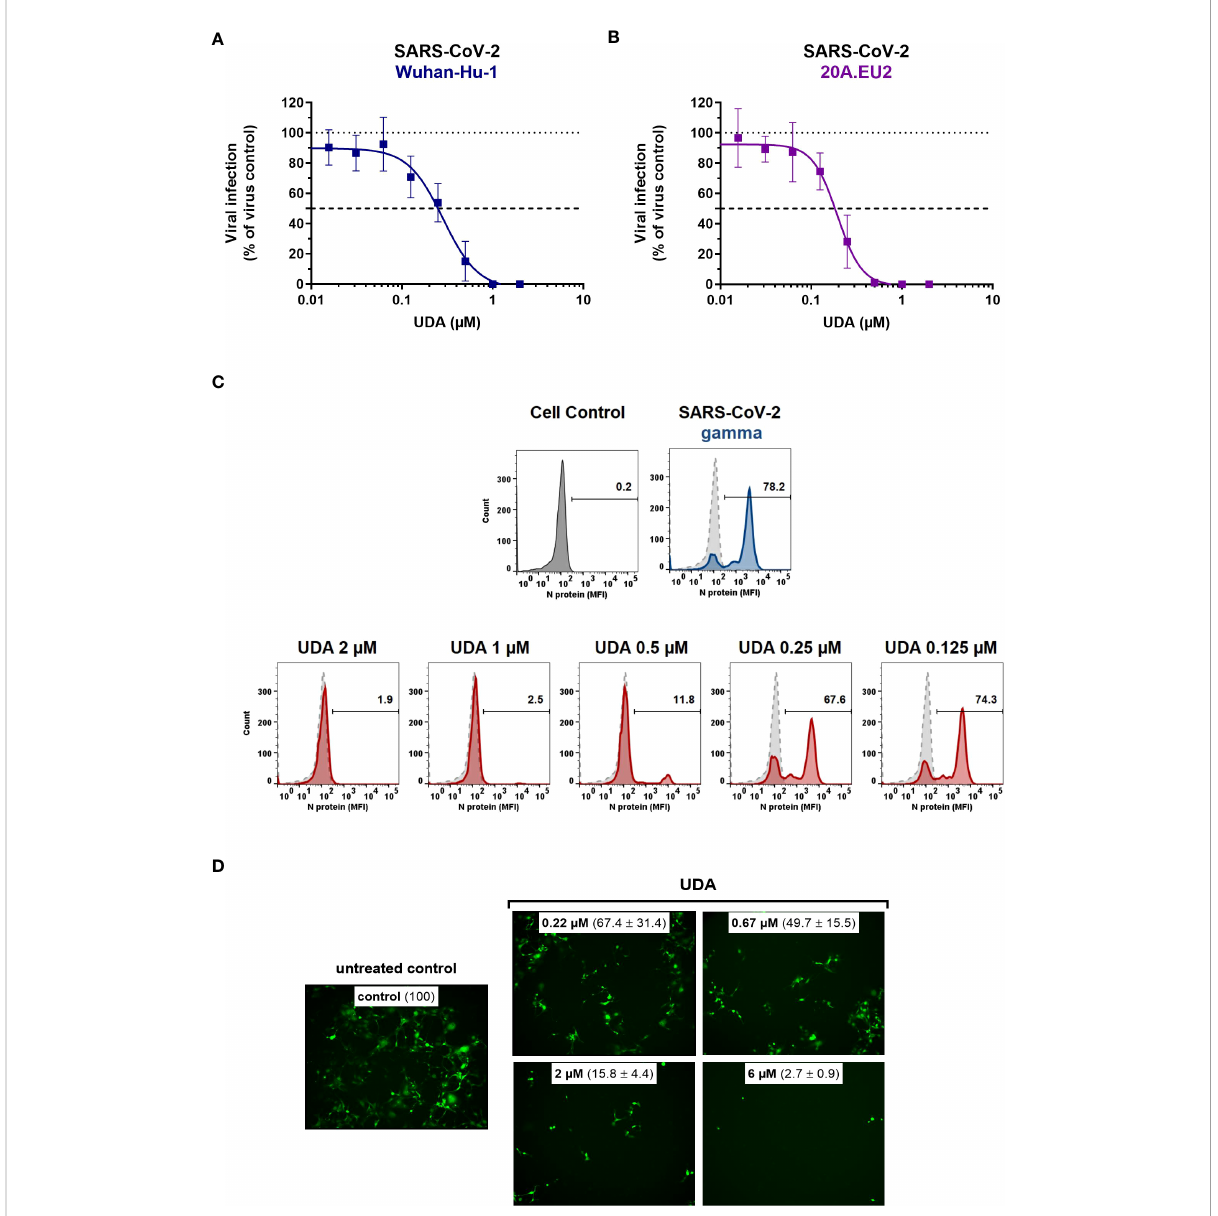
FIGURE 2 Antiviral activity of UDA against live SARS-CoV-2 virus in Vero E6 and U87.ACE2 + cells. Cells were exposed to clinical isolates of SARS-CoV-2, i.e., variants Wuhan-Hu-1 (A) , 20A.EU2 (B) , Gamma (C) or GFP-expressing Wuhan-Hu-1 (D) in the absence or presence of UDA. (A , B) SARS- CoV-2 replication was assessed by RT-qPCR analysis of the viral copy numbers of the N gene in the supernatant at day 3 post infection (p.i.). RT-qPCR data were used to calculate the % inhibition of viral replication and to plot a concentration-response curve for UDA. Graphs show data of 3 independent experiments with 2 technical replicates each (mean ± SD; n=6). (C) Cells were collected at 40h p.i. and stained intracellularly for the viral N protein. Histogram plots show mean fl uorescence intensity (MFI) values of N expression in noninfected (Cell Control; grey), infected (Virus Control; blue) and UDA-treated infected (red) Vero E6 cells from a representative experiment. Single cell analysis was performed on 8,000 – 10,000 cells by fl ow cytometry. The numbers in each plot refer to the percentage of cells that stained positive for N (i.e., infected cells). The dashed grey histogram plot represents the background signal from the non-infected cell control. (D) Pictures, taken at 2 days post infection, show GFP expression in the infected U87.ACE2 + cells. Representative pictures from a biological replicate out of two are shown. The values between brackets refer to the percentage GFP + area (relative to the virus control); mean ± SD